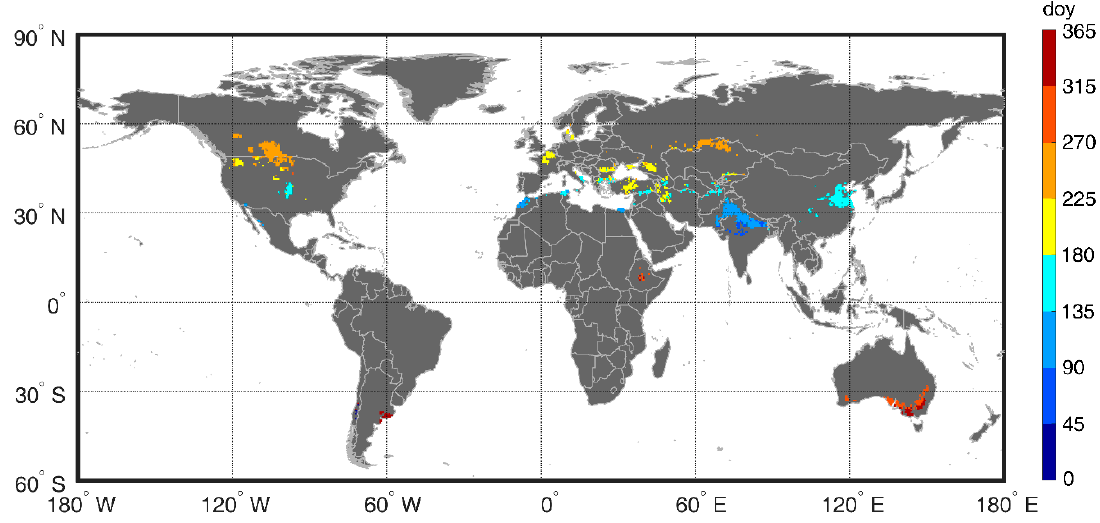
Figure 2. The spatial distribution of multiyear and multimethod average wheat harvest date (WHD). The “doy” in the color bar denotes the day of year.